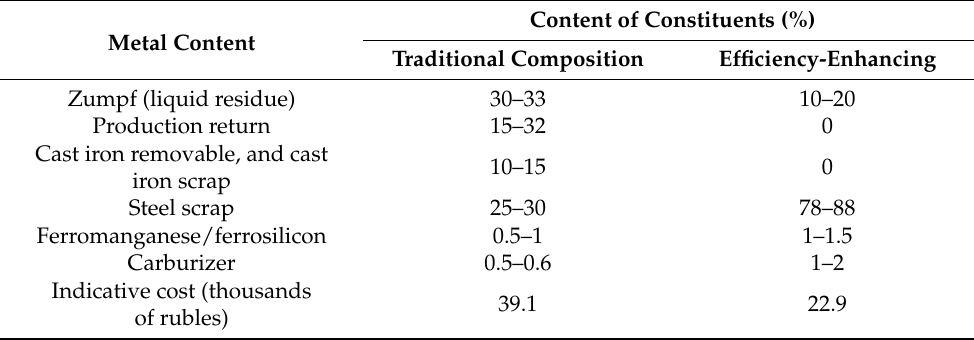
Table 2. Composition of metal scrap for different amounts of steel